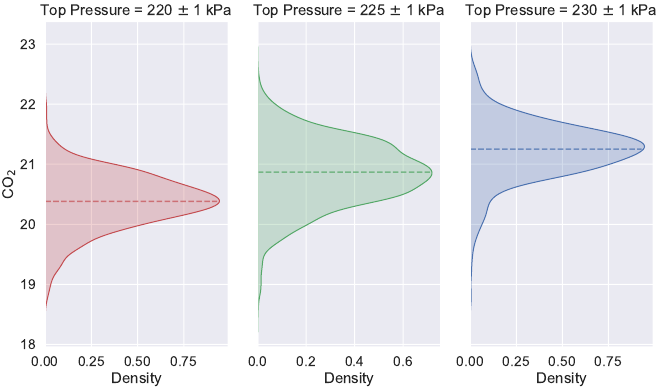
Figure 3. Variation of the posterior distribution of the detection variables with the change of opera- tional variable. The horizontal axis is the probability density value of the distribution of the carbon dioxide. The vertical axis shows the value of the volume fraction of the carbon dioxide flow at the top of the furnace.